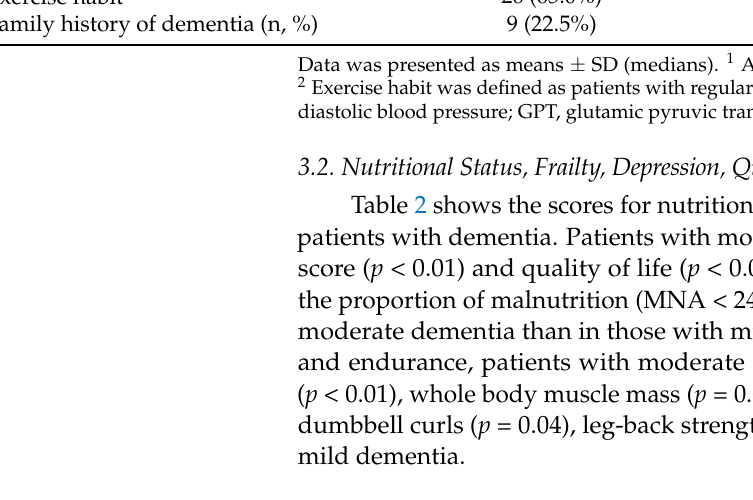
Table 2. Nutritional status, frailty, depression, quality of life, and muscle mass, strength, and endurance of patients with